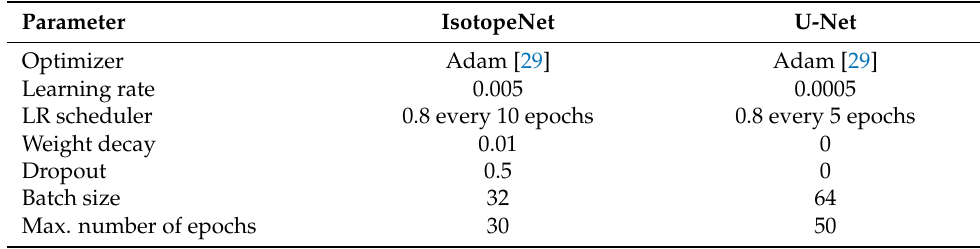
Table A1. Hyperparameters for IsotopeNet and